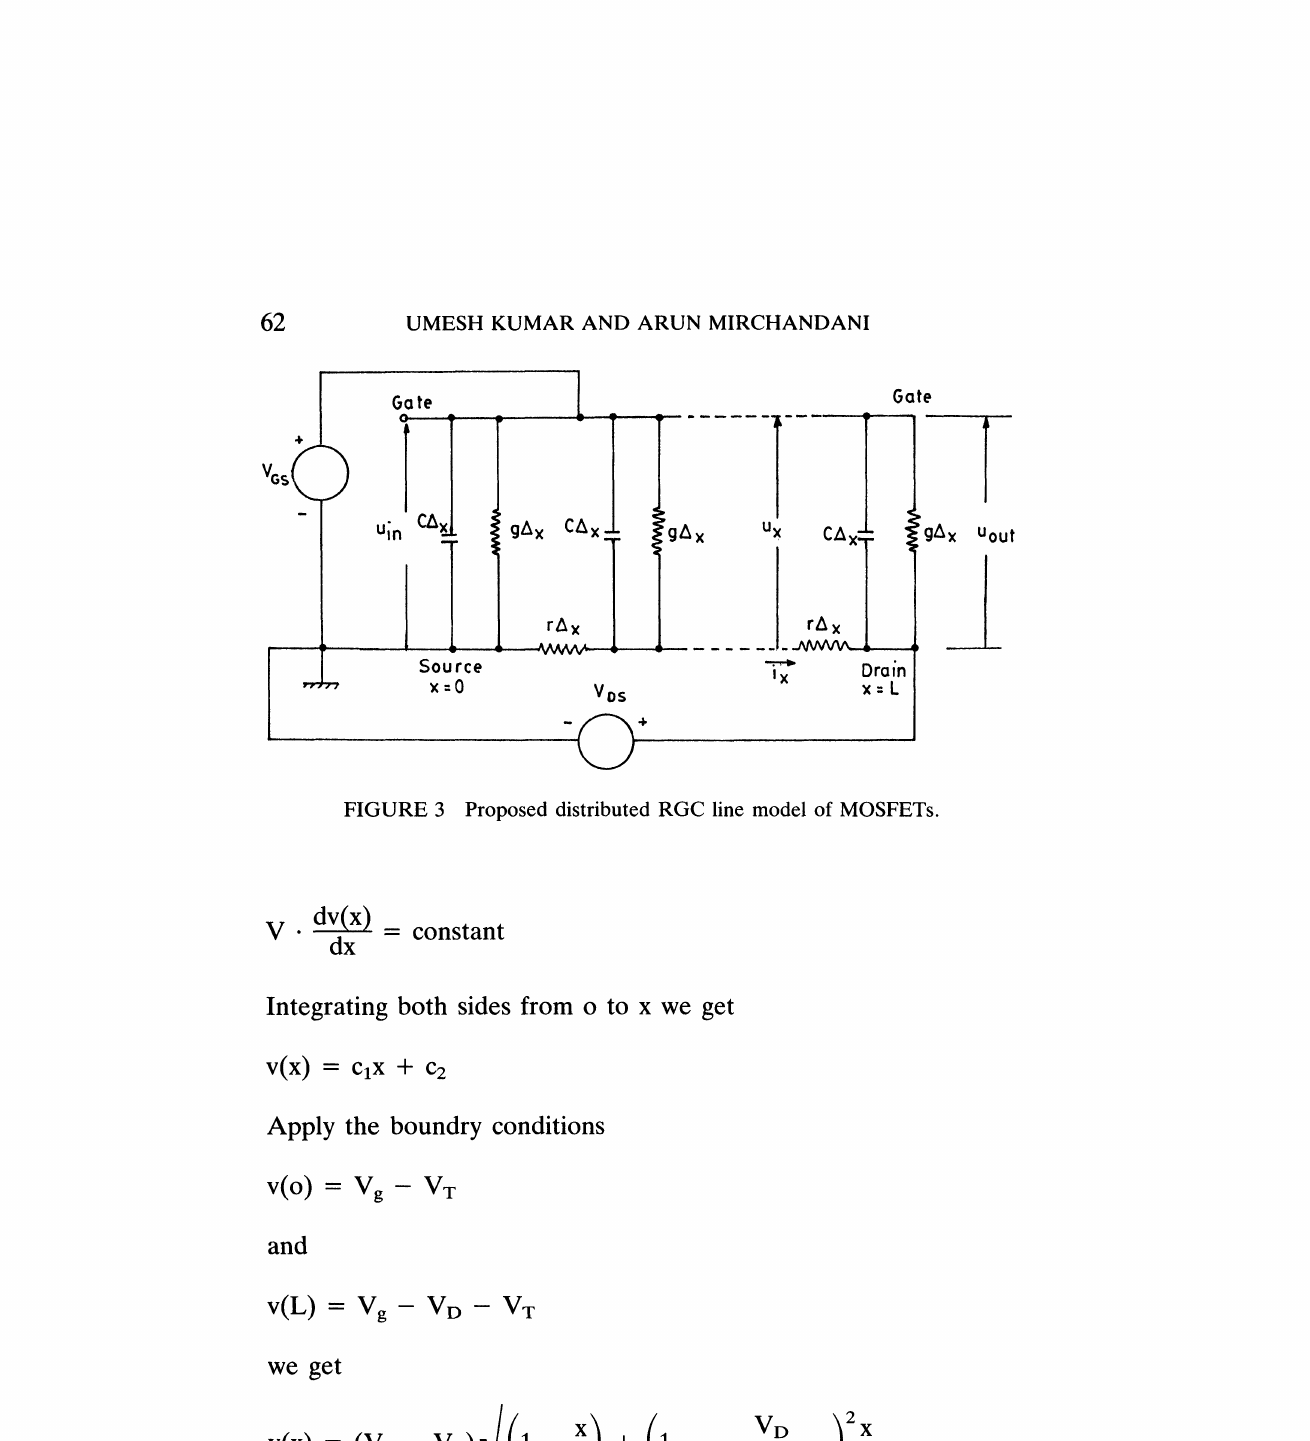
FIGURE 3 Proposed distributed RGC line model of